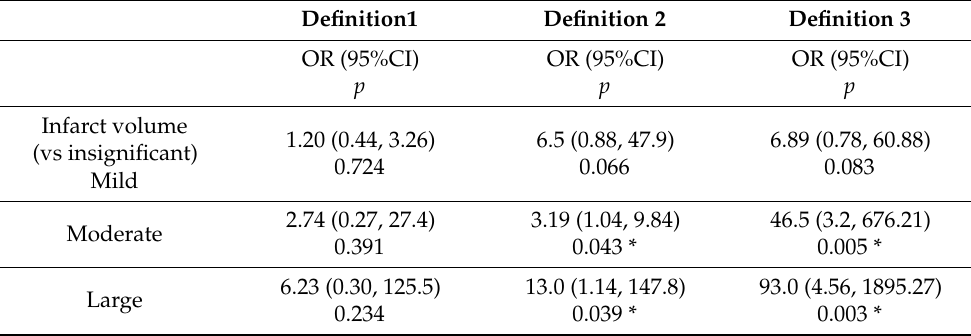
Table 2. Univariate logistic regression of the risk of selected volumes of acute ischemic infarcts among clopidogrel-resistant versus -sensitive subjects, depending on three different definitions of the